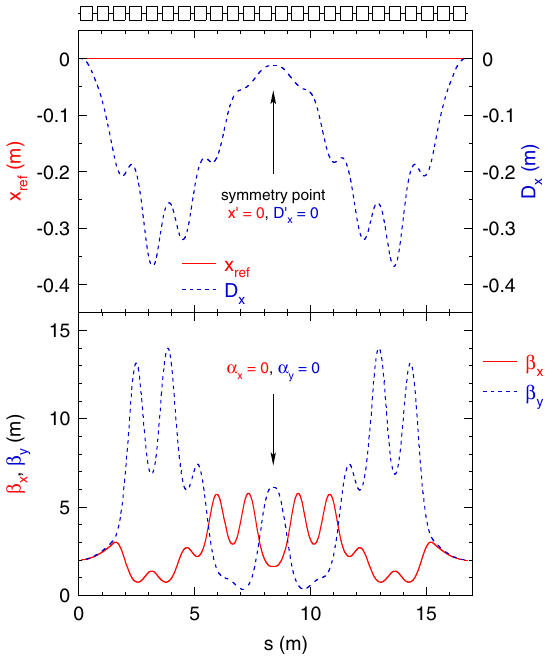
FIG. 4. 2 : 4 GeV =c optics of an outward-bending superperiod: the horizontal reference orbit x ref and dispersion D x (top) and the horizontal and vertical (cid:1) functions (bottom).